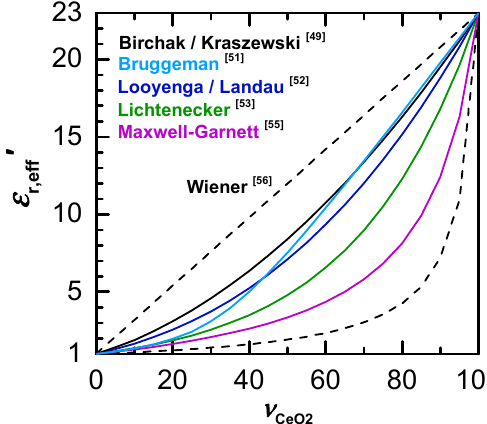
Figure 5. E ff ective dielectric constant of ceria powder, ε r,e ff (cid:48) , as it depends on volume fraction ν CeO2 of Figure 5. Effective dielectric constant of ceria powder, ε r,eff (cid:4593) , as it depends on volume fraction ν CeO2 ceria, according to some dielectric mixing models from of ceria, according to some dielectric mixing models from literature.